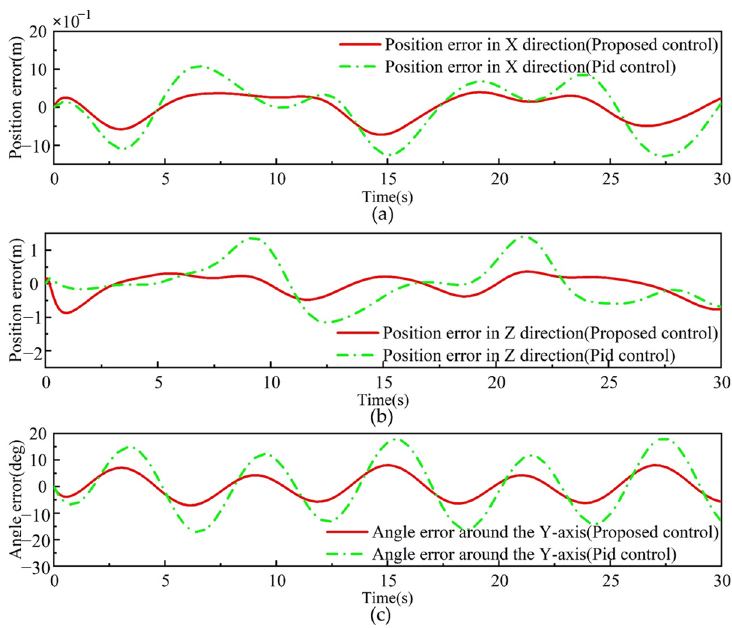
Figure 10. Comparison of tracking error of different controllers at v = 0.6 m/s: ( a ) Position error in X direction; ( b ) Position error in Z direction; ( c ) Angle error around the Y-axis.